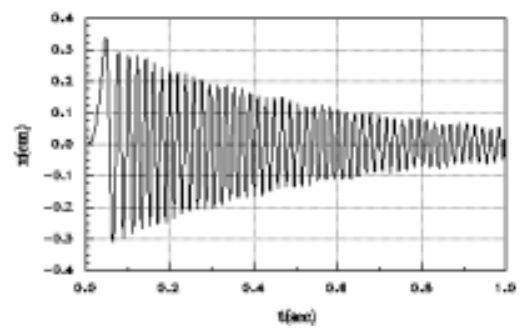
Fig. 4. The covariance of displacements x 1 and x 2